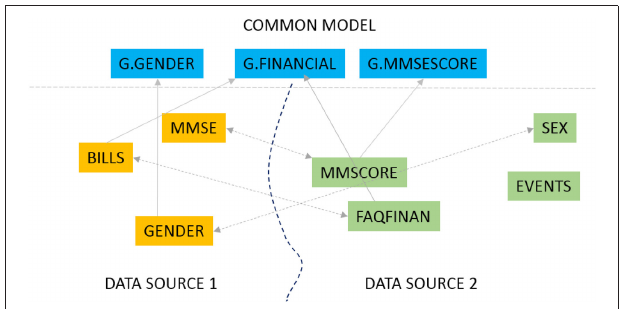
FIGURE 1 | Data element